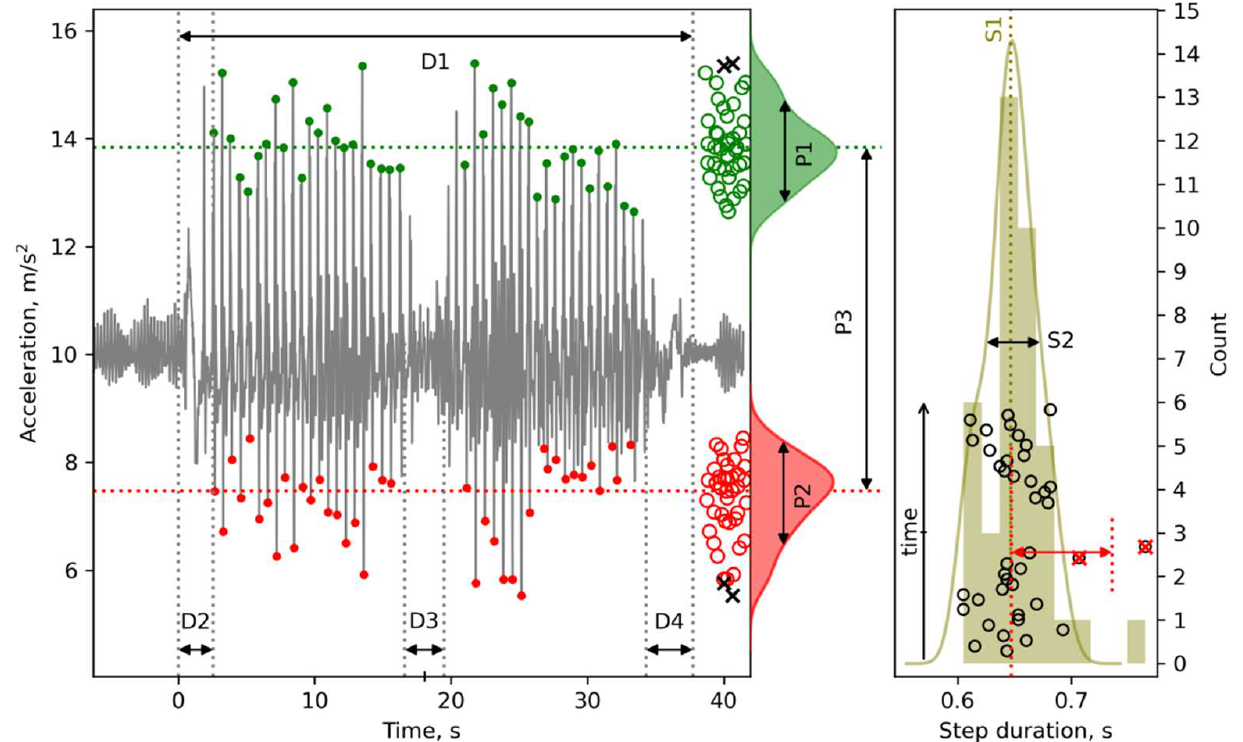
Figure 2. A representative plot of the 13 m TUG test with the phases (D1–D4) and parameters P1–P3 determined with an accelerometer ( left panel ) and the moments of step duration distribu- tion (S1–S2, right panel ) along progression of time.